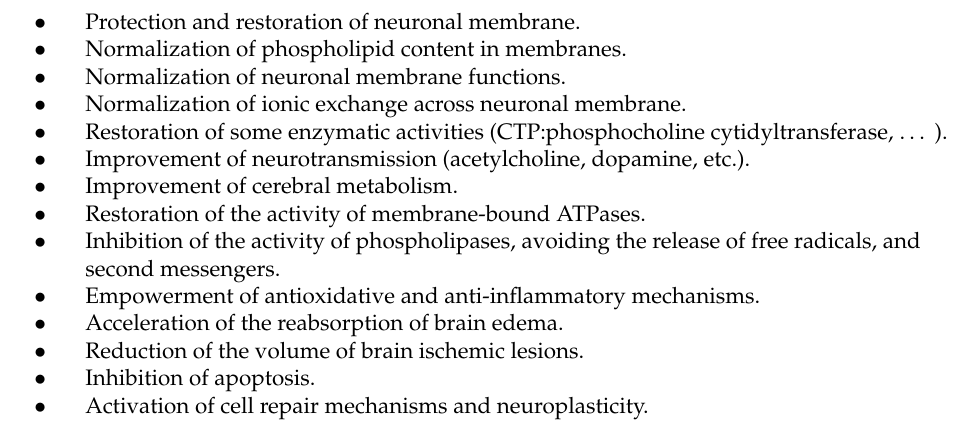
Table 2. Main actions of citicoline on experimental models of